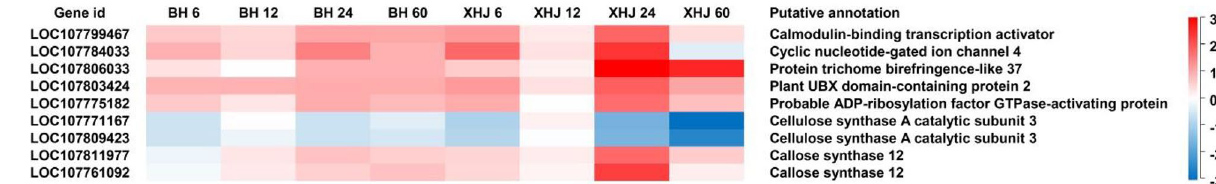
Figure 7. Expression profiles in BH and XHJ of 9 S gene homologs specifically identified in XHJ. Genes in red are upregulated whereas those in blue are downregulated. The regulation of genes is based on log2 fold change compared to the mock-infected control samples.